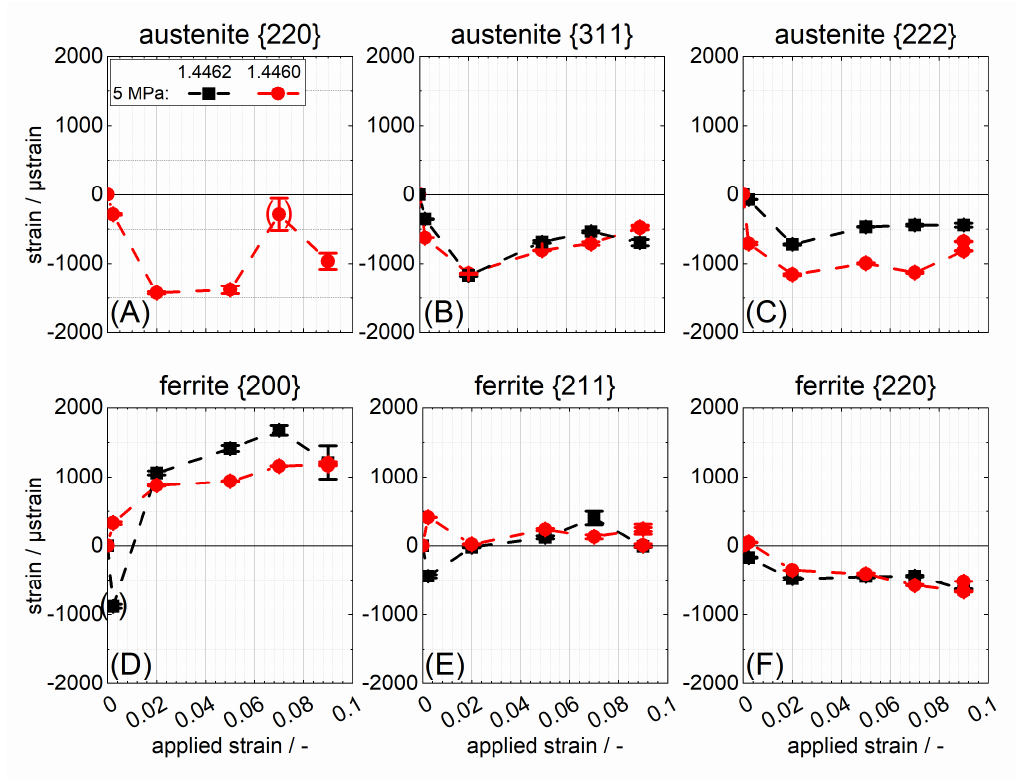
Figure 10. The {hkl}-specific (residual) strain when unloaded to 5 MPa above the previously applied load stress. ( A – C ) Duplex stainless steel 1.4462; ( D – F ) steel 1.4460.